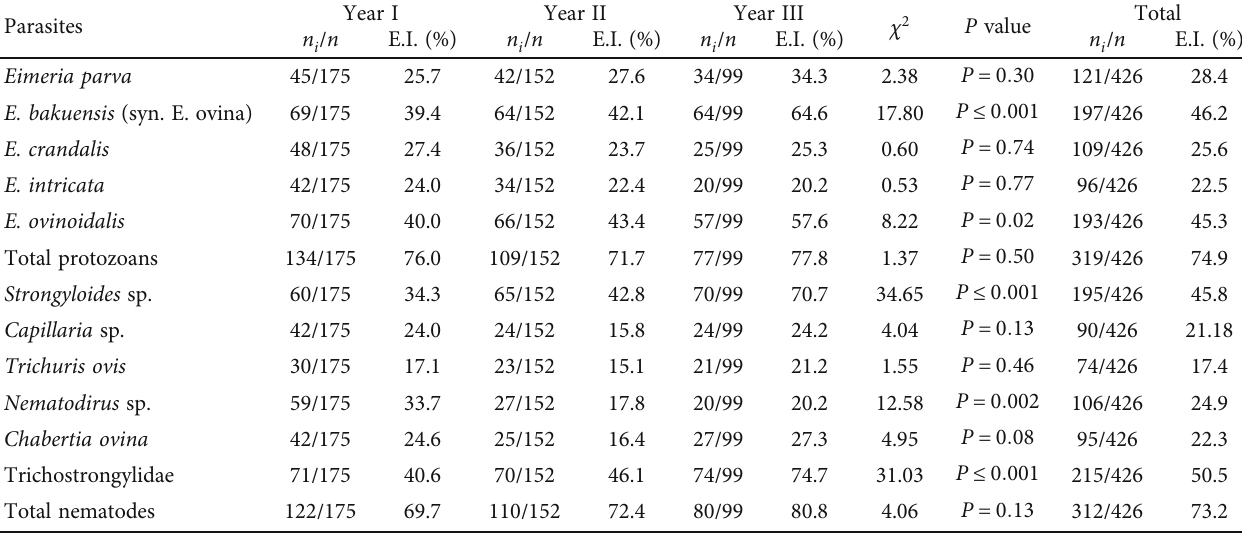
Table 1: Prevalence (%) of Eimeria protozoans and gastrointestinal nematodes in mou fl ons in the experimental period.